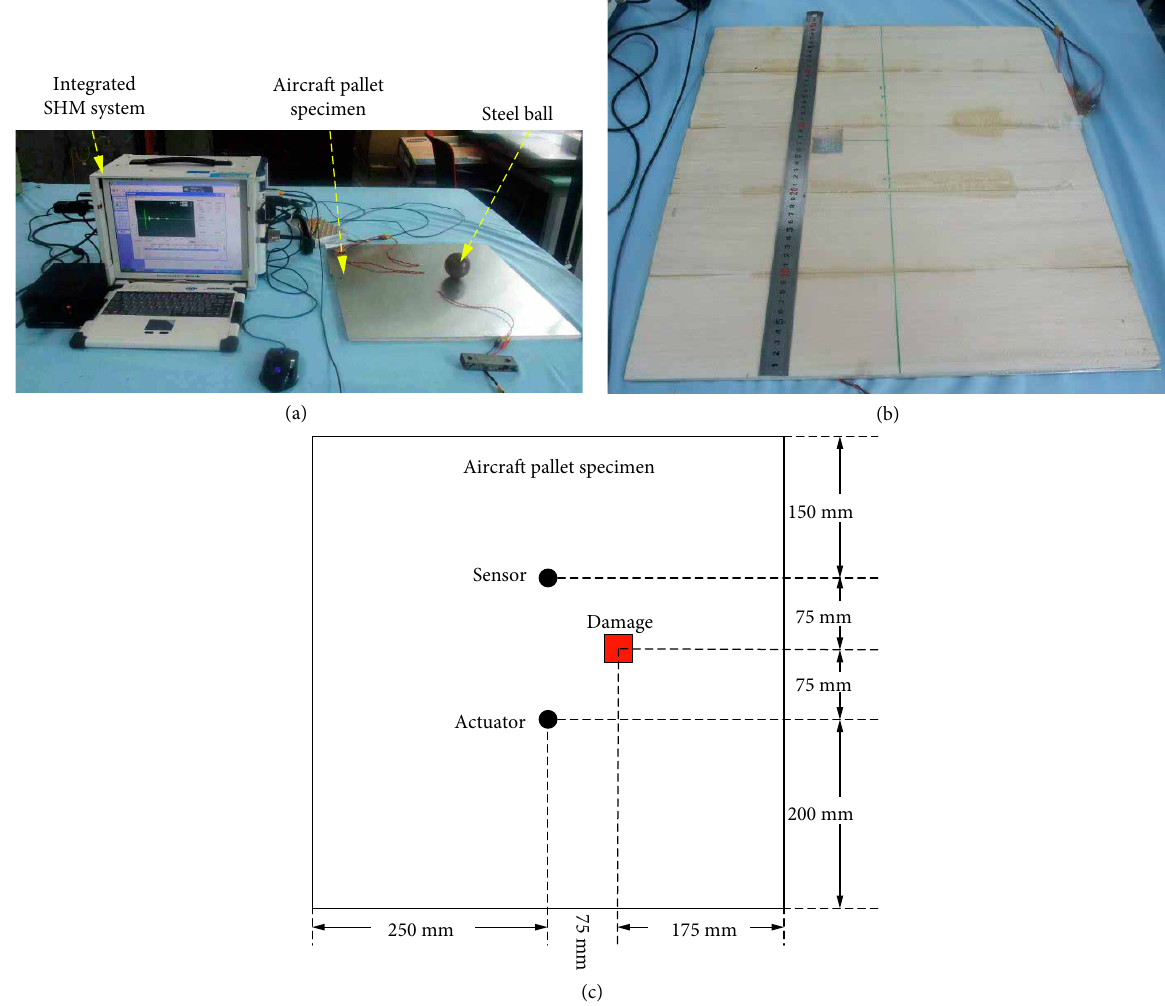
Figure 5: Illustration of the experimental system for frequency selection and aircraft pallet damage simulation. (a) Experimental setup; (b) real damage; (c) positions of piezoelectric transducer sensors and damage.